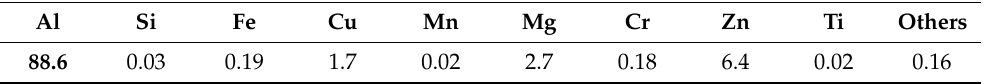
Table 1. Chemical composition of the 7075-T651 aluminum alloy (weight